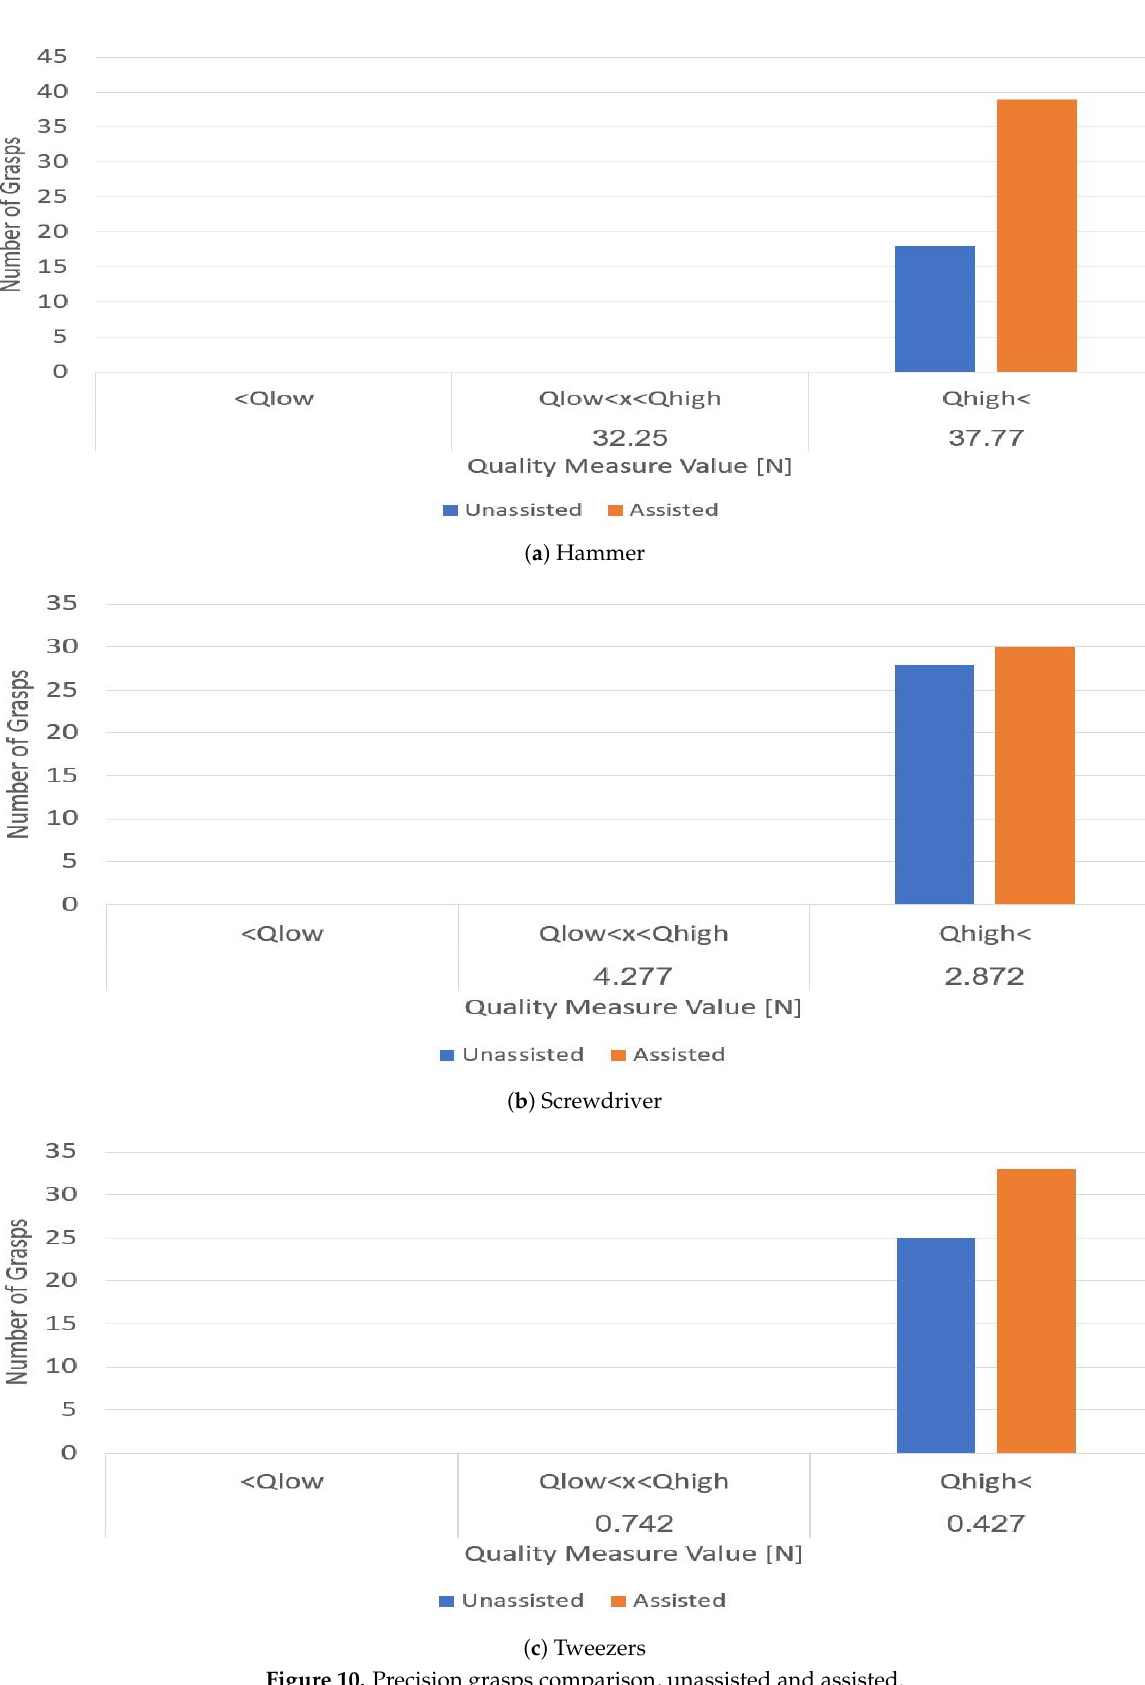
Figure 10. Precision grasps comparison, unassisted and